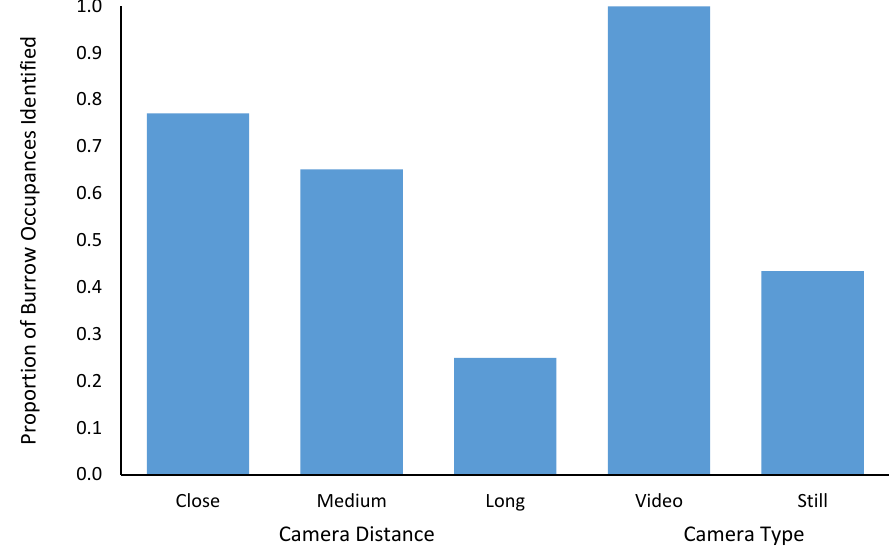
Figure 3. The proportion of burrow occupancies (entry into or exit from a burrow which provided positive evidence of a wombat occupying the burrow during the day) which we could identify from imagery recorded on different camera combinations.